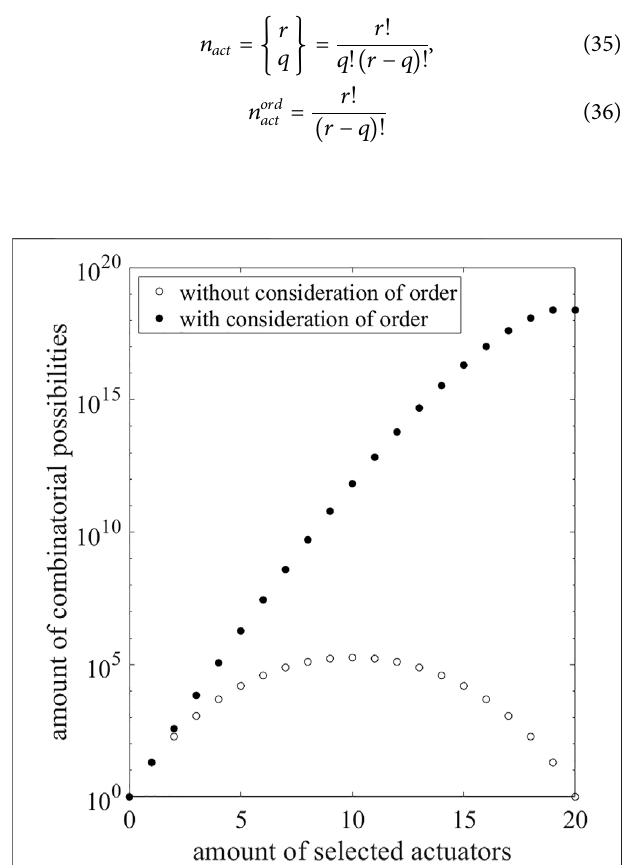
FIGURE 2 | Number of combinatorial possibilities for the selection of an amount of actuators for r = 20 rods with and without consideration of the